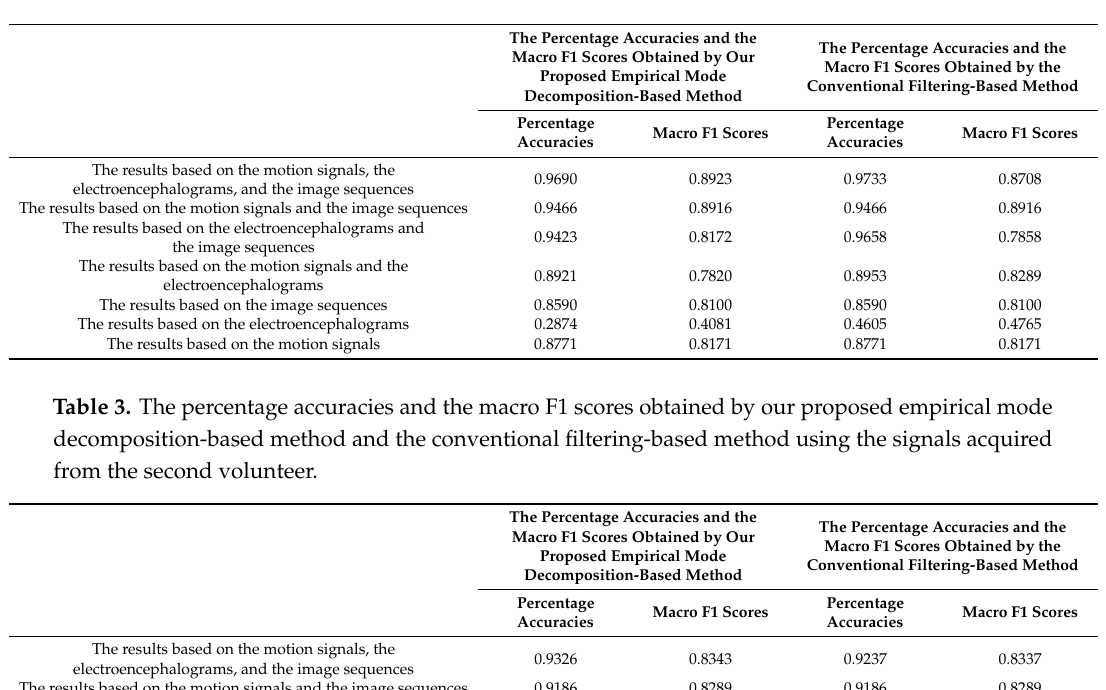
Table 2. The percentage accuracies and the macro F1 scores obtained by our proposed empirical mode decomposition-based method and the conventional filtering-based method using the signals acquired from the first volunteer.